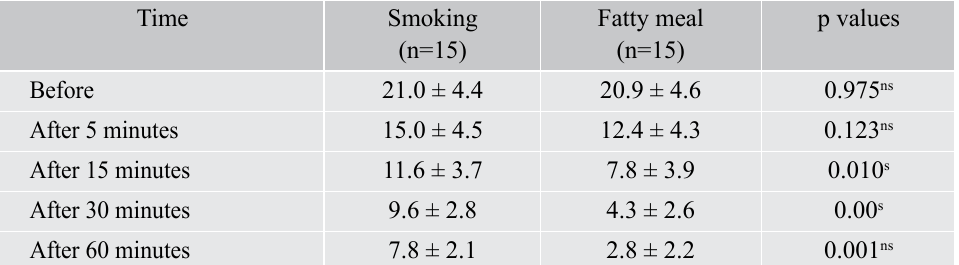
Table III: Mean comparison of gallbladder volume (in cm 3 ) after smoking and fatty food intake in Group I (n=15)